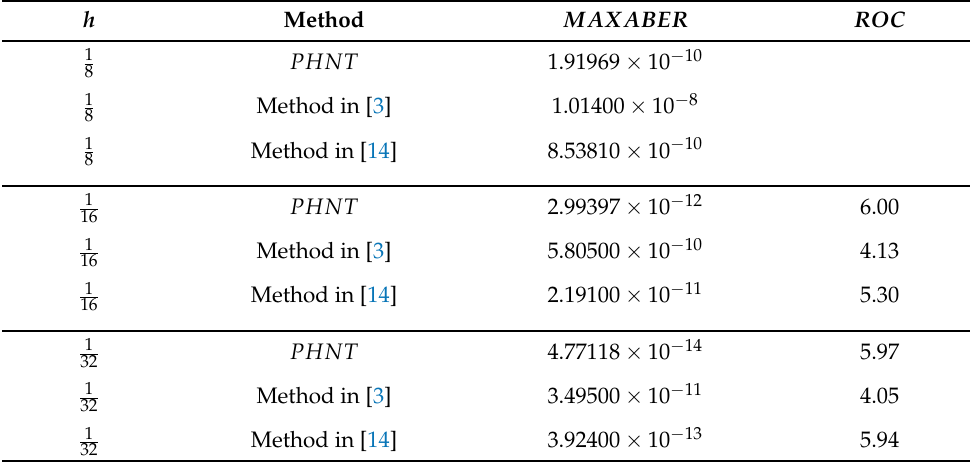
Table 2. Maximum absolute errors (MAXABER) for test problem 3.